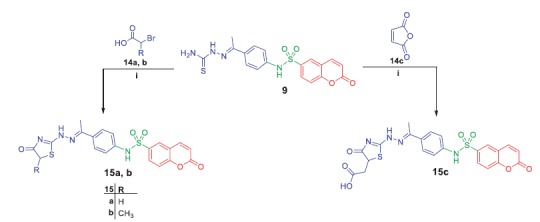
Synthesis of target compounds 15a–c; Reagents and conditions: (i) AcOH/anhydrous AcONa/reflux 8h.